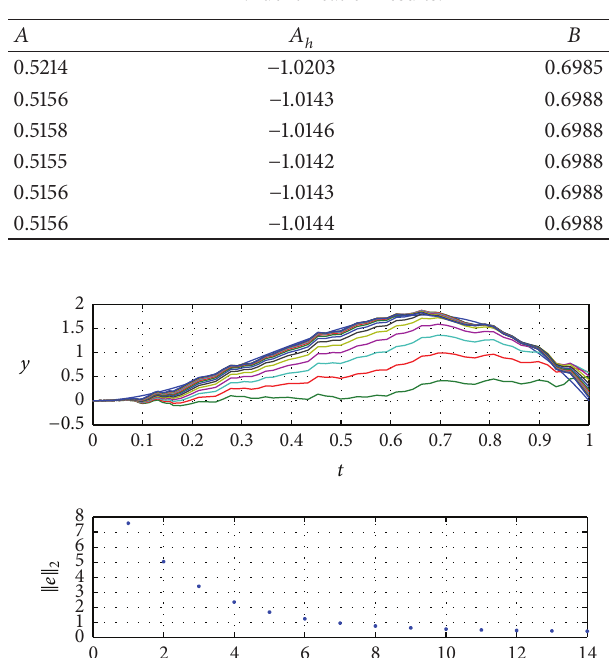
Table 1: Identification results.